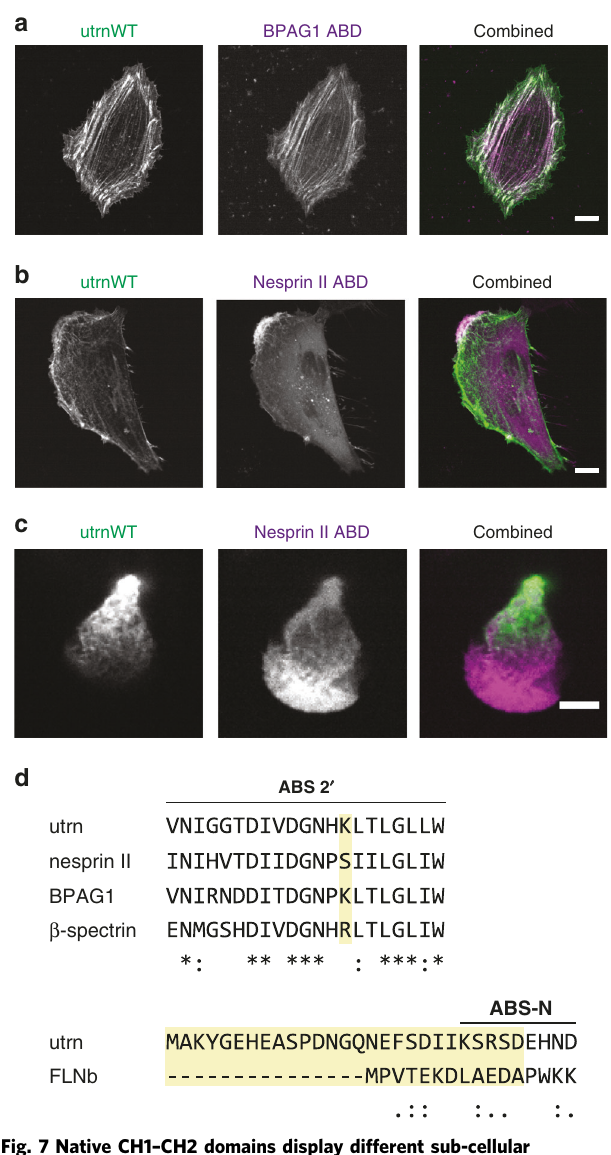
Fig. 7 Native CH1 – CH2 domains display different sub-cellular localizations. a Localization of BPAG1 ABD (magenta) relative to utrnWT (green) in HeLa cells. Scale bar is 5 µ m. b Localization of Nesprin II ABD (magenta) relative to utrnWT (green). c Localization of Nesprin II ABD (magenta) relative to utrnWT (green) in PLB cells. Images shown are representative examples taken from a set of at least 10 different images. Scale bar is 5 µ m. d Sequence alignment of native CH1 – CH2 domains. Residue K121 for utrnWT highlighted in yellow (top) and the N-terminal region prior to CH1 – CH2 and its truncation in yellow (bottom). Identical residues are annotated with ‘ * ’ , strongly conserved with ‘ : ’ , and weakly conserved with ‘ . ’